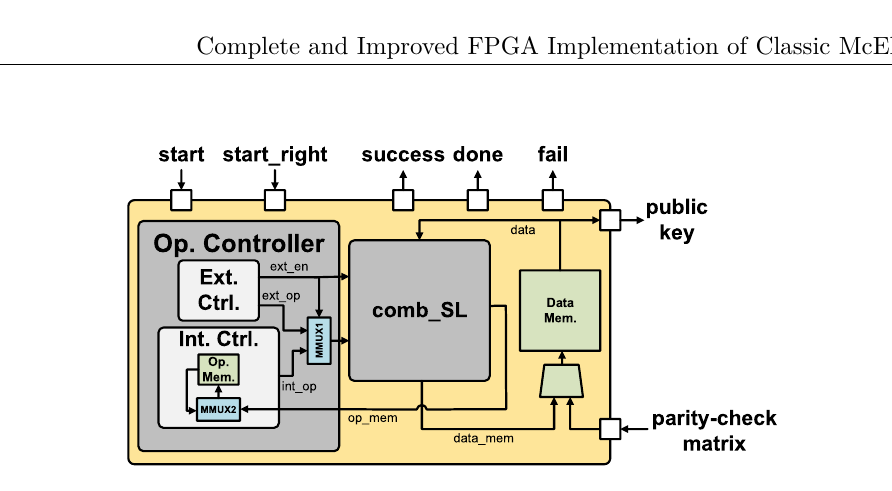
Figure 6: Hardware structure of the HEA systemizer design. Each wire in the diagram is of width s (the column-block width), and the processor array is of dimension s × s